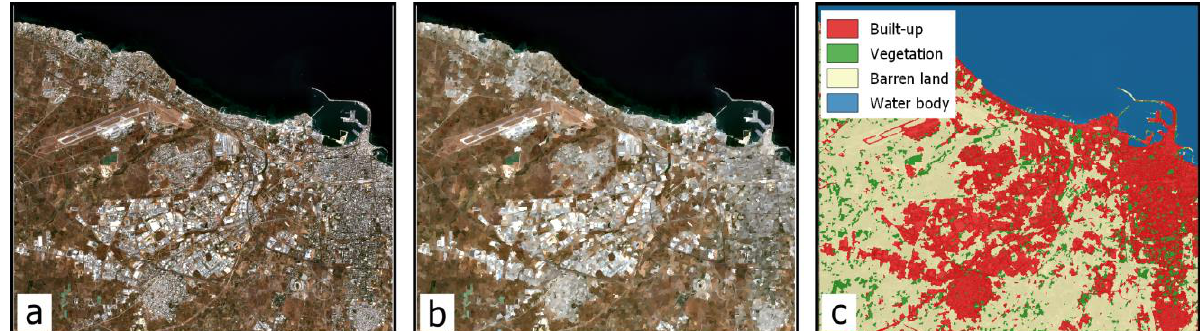
Figure 8 . Bari natural color composite (a), segmented natural color composite (b), and classification result